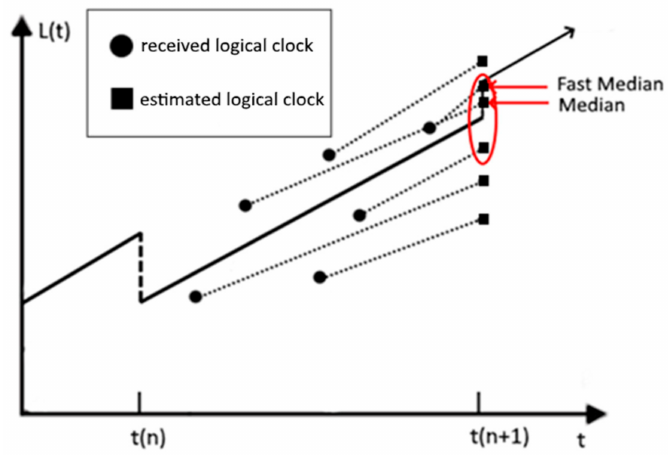
Figure 4. Median value in synchronization